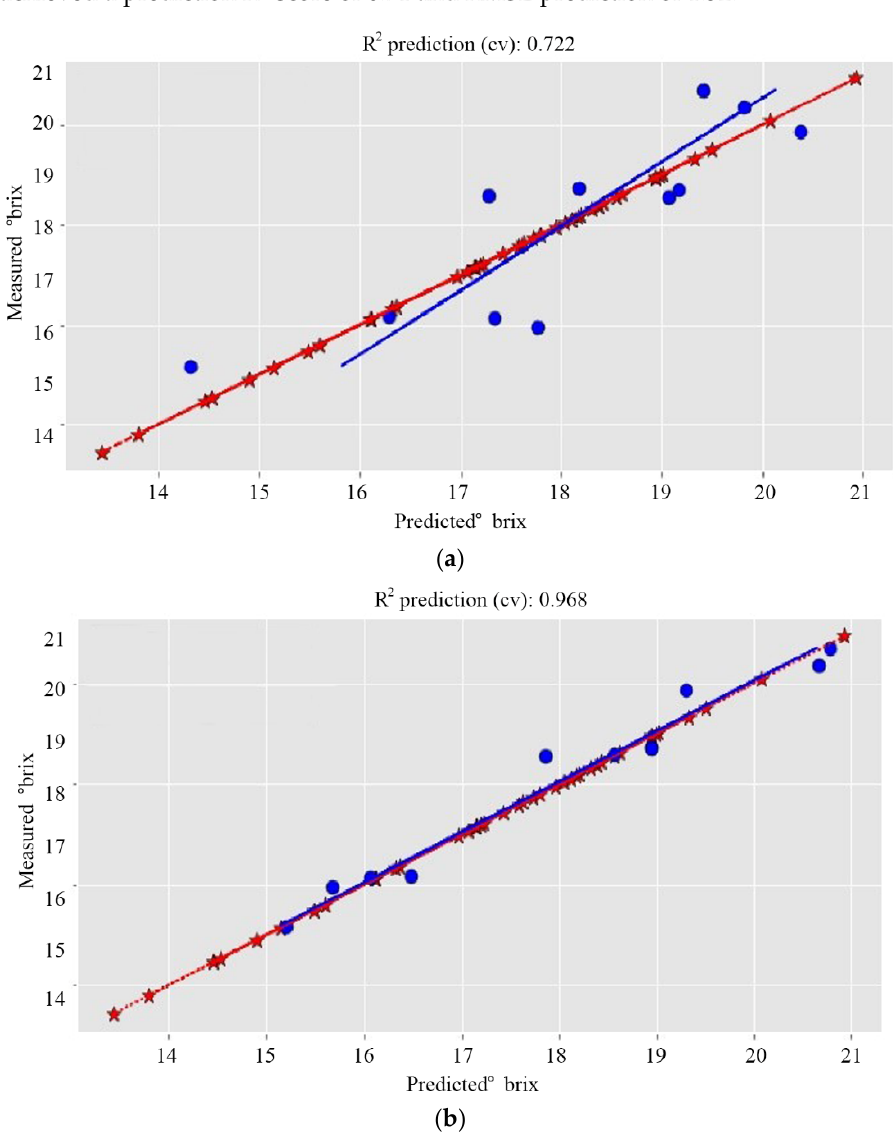
Figure 2. MLR results. ( a ) Plots of calculated and predicted TSS, derived from the entire dataset 1 (harvest 1) of reflection FT-NIR spectra, against the chemometrically measured (actual) values. The line fitting the asterisk scatter plot represents a plot of the calculated by the regression model against the actual TSS values. The line fitting the scatter plot of the circles represents a plot of the predicted by the regression model against the actual values. ( b ) Same plot using the selected wavenumber dataset (absxcoefs) of the same harvest 1. The two lines, that of prediction and that of calculation from the model, almost coincide against the actual